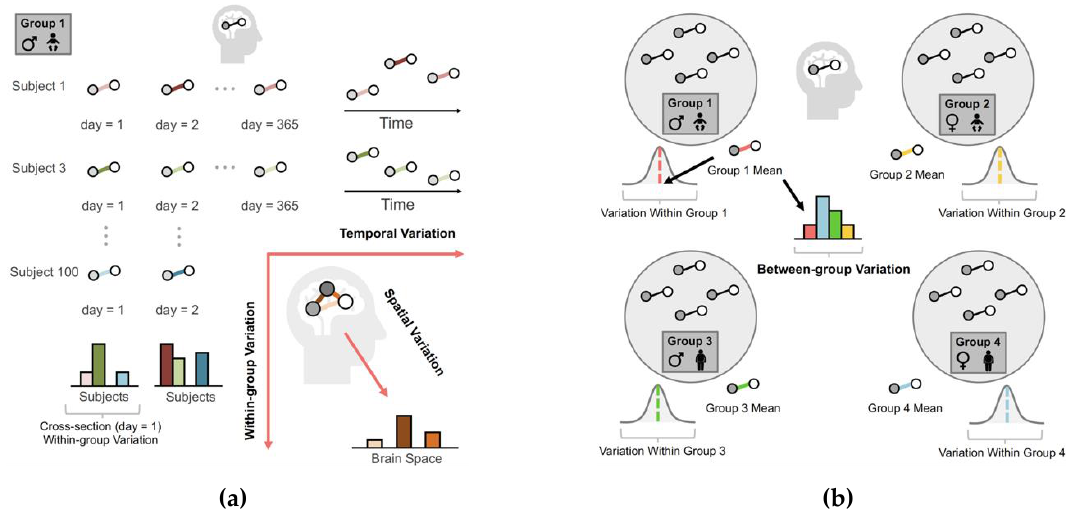
Figure 1. Three types of population and variation in human neuroscience. ( a ) Variation within a group. For a group of male toddlers, the three types of variation are defined according to time, (brain) space, and individuals. From left to right: temporal variation. From top to bottom: within-group variation. Bottom right: spatial variation. Note that for temporal and within-group variations, one edge is considered, while for spatial variation, multiple edges are considered since the latter considers variability across brain regions. For demonstration purposes, we show the spatial variation for one subject. ( b ) Variation between groups. We consider the variation of an edge between two brain regions in four groups (male toddlers, female toddlers, male adults, and female adults). The between-group variation quantifies the variance of group mean edge strength (coloured edges in the